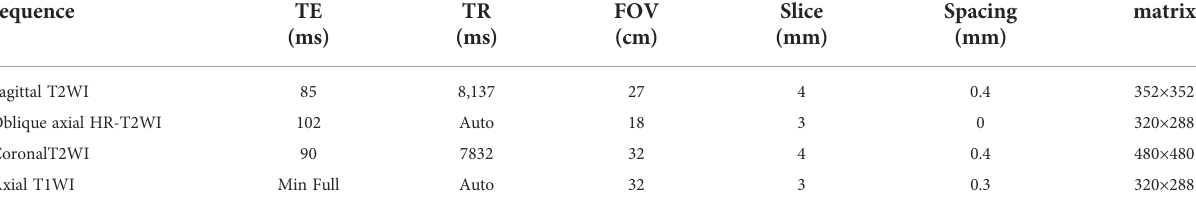
TABLE 1 The scanning sequences with parameters applied in this